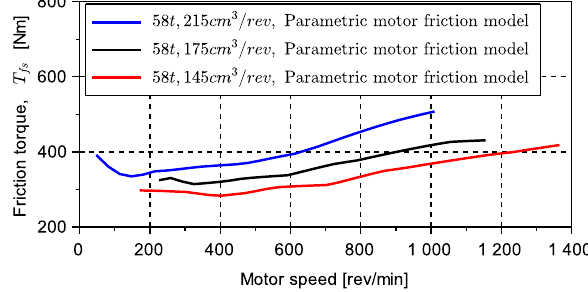
Figure 11: System friction derived from